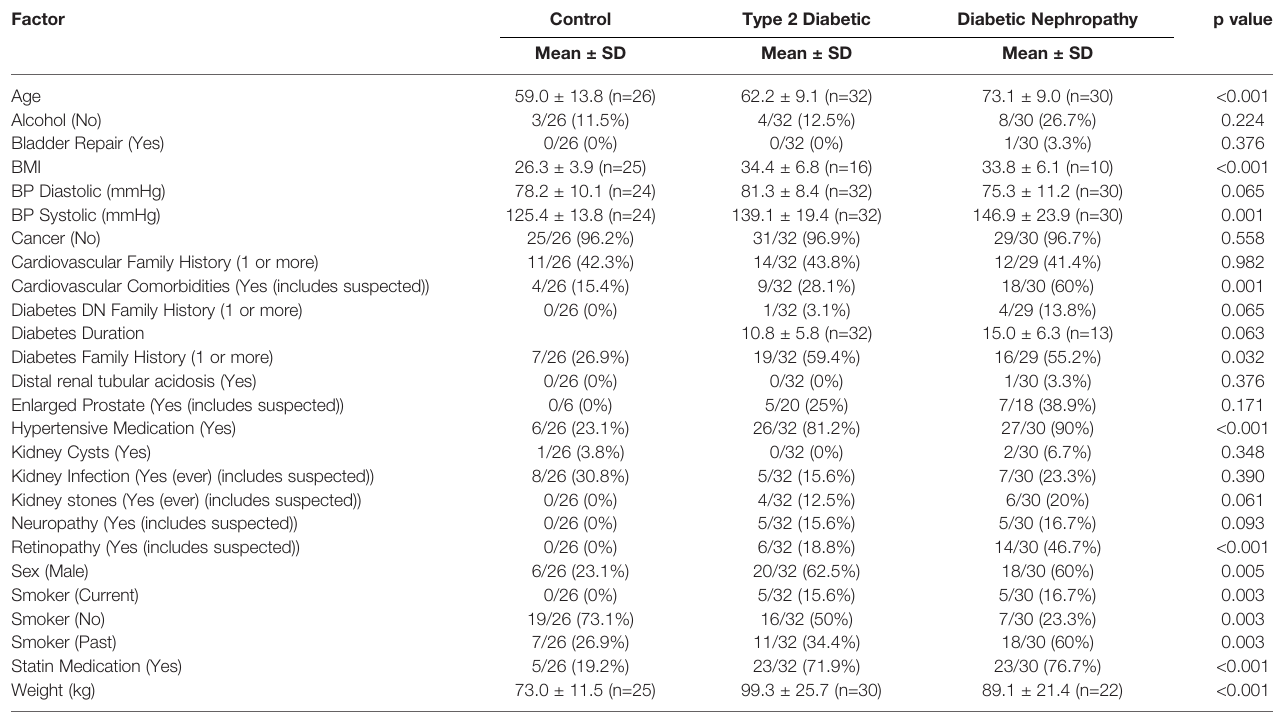
TABLE 1 | Clinical and demographic characteristics of the study participants.